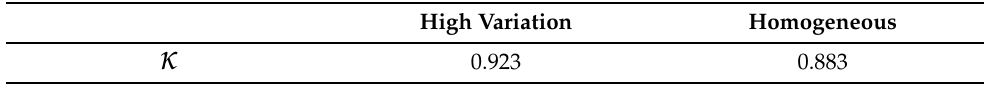
κ for high moisture Table 3.